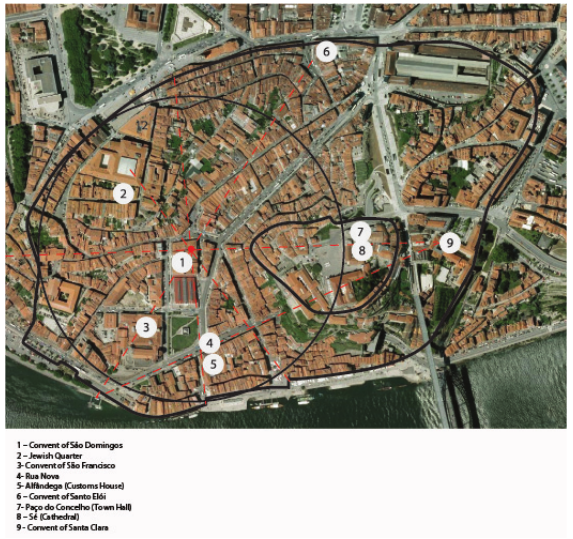
Figure 3: City plan in the 14th century